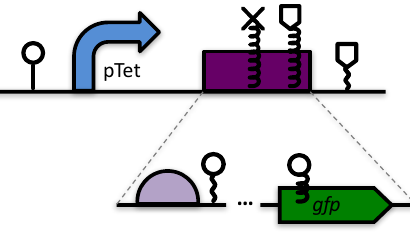
Figure 34: Detailed design of a promoter, in which the transcription start site is preceded by two operator sites where regulators bind, and the whole is flanked by insulators.